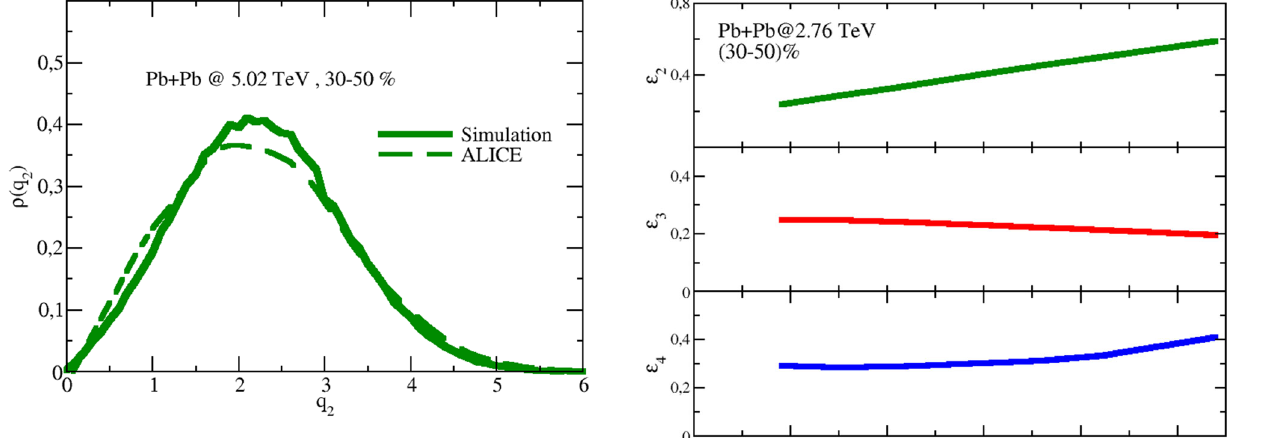
Fig. 2 Distribution of charged particles at mid-rapidity ( | η | < 0 . 8) as a function of the reduced flow vector q 2 . In the transverse momentum range 0 . 2 < p T < 5 GeV / c for the 30 − 50% centrality class in 5 . 02 TeV PbPb collisions, compared to the ALICE measurements taken from [59]